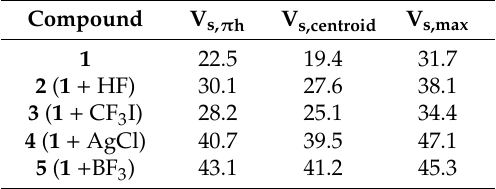
Figure 3. Molecular electrostatic potential (MEP) surfaces plotted onto the van der Waals surface (0.001 a.u.) for complexes 2 – 5 using the same scale. The MEP values are given in kcal mol − 1 . The asterisk represents the location of the maximum (V s,max ). Table 1. MEP values (PBE0-D3 / def2-TZVP in kcal mol − 1 ) at the π -hole and ring centroid (V s, π h , V s,centroid respectively) and at the maximum V s,max in compounds 1 – 5.